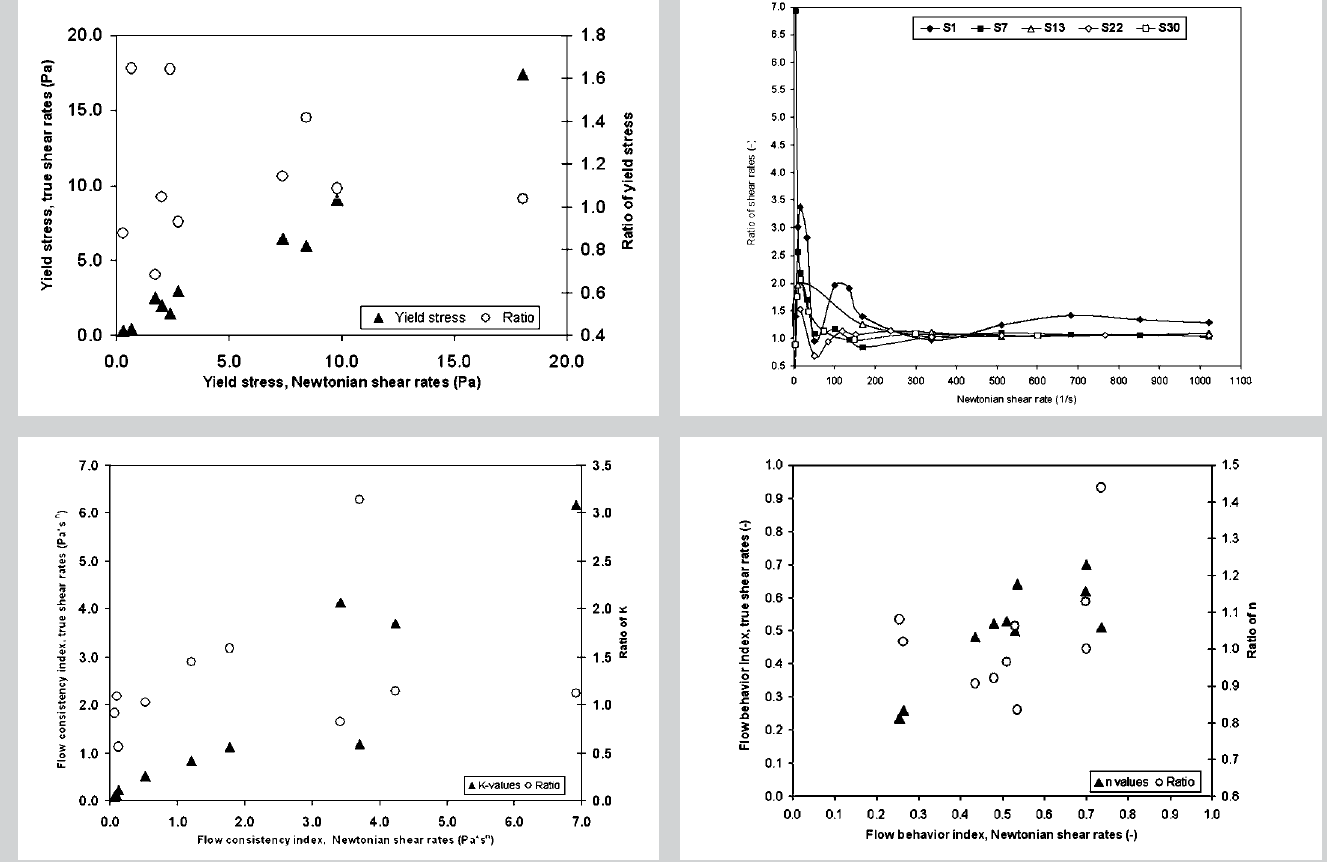
Figure 1 (left above): Comparison of yield stresses computed using Newtonian shear rates with yield stress- es computed using true shear rates and their ratios, for all samples from Table 2. Figure 2 (right above): Ratio of true shear rates over Newtonian shear rates for various samples. Figure 3 (left below): Comparison of consistency index computed using New- tonian shear rates and of con- sistency index computed using the true shear rates, and their ratios, for all samples. Figure 4 (right below): Comparison of flow behavior index computed using New- tonian shear rates and of flow behavior index comput- ed using true shear rates, and their ratios, for all